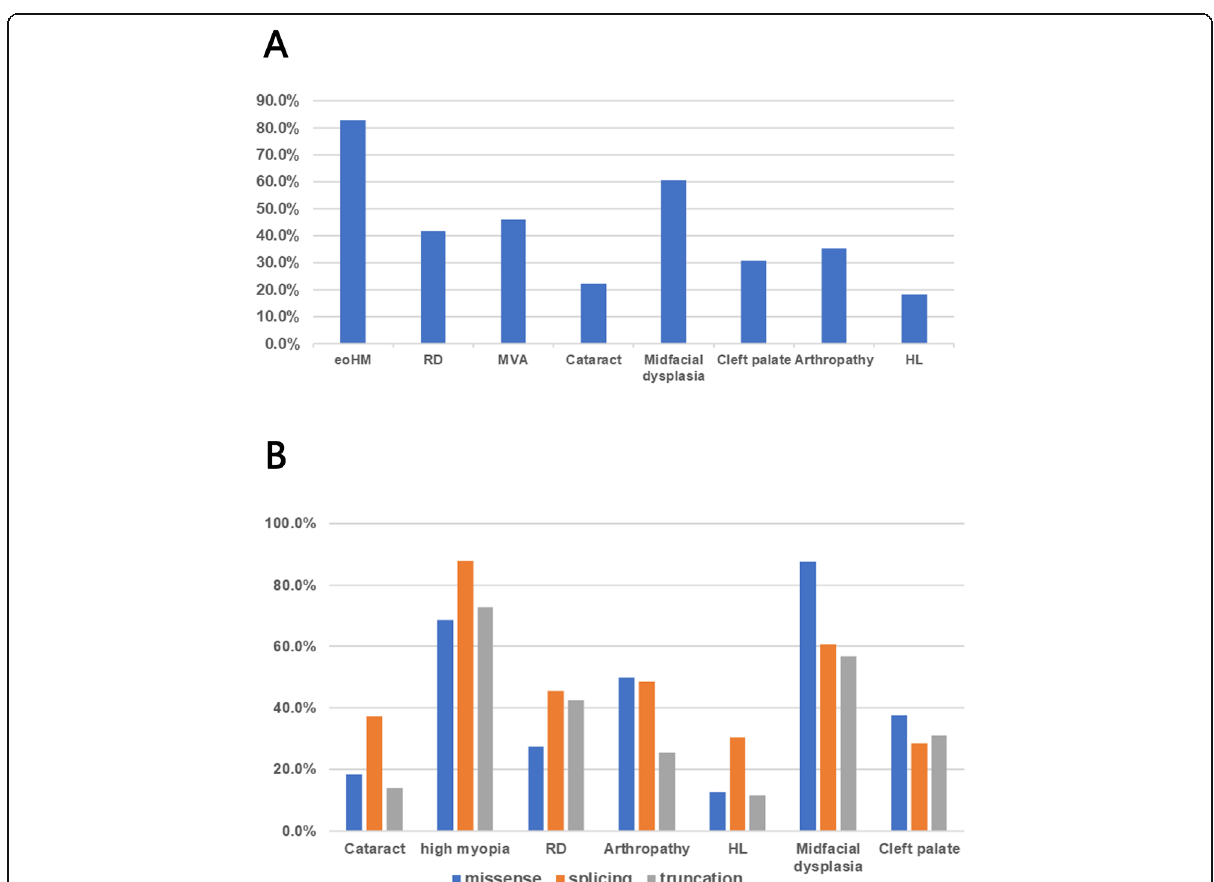
Fig. 3 The clinical characteristics of 107 patients with STL1 in East Asia. a The prevalence of different phenotypes in STL1. b The prevalence of different phenotypes among 3 subgroups. eoHM: early-onset high myopia; RD: retinal detachment; MVA: membrane vitreous abnormalities; HL: hearing loss